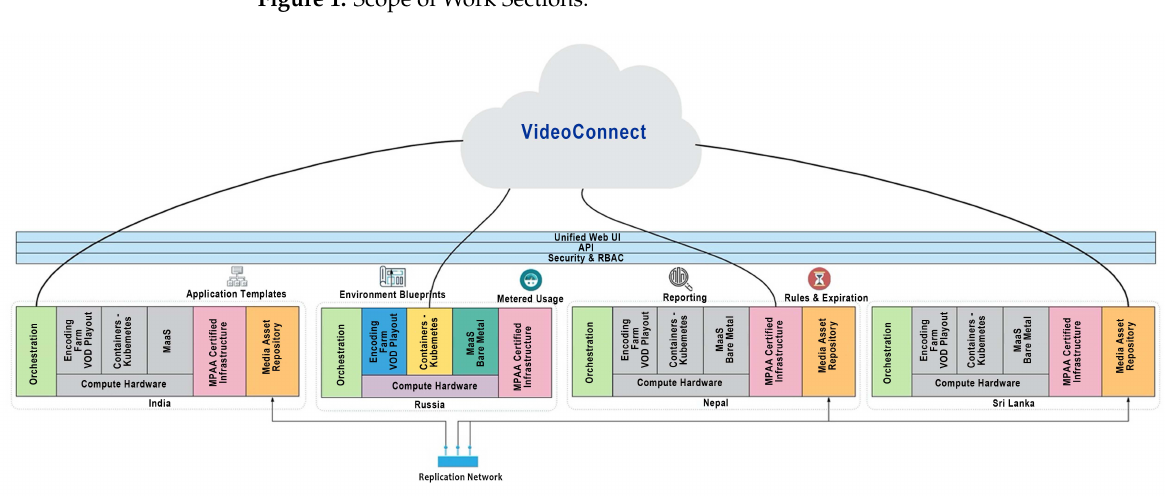
Figure 1. Scope of Work Sections.